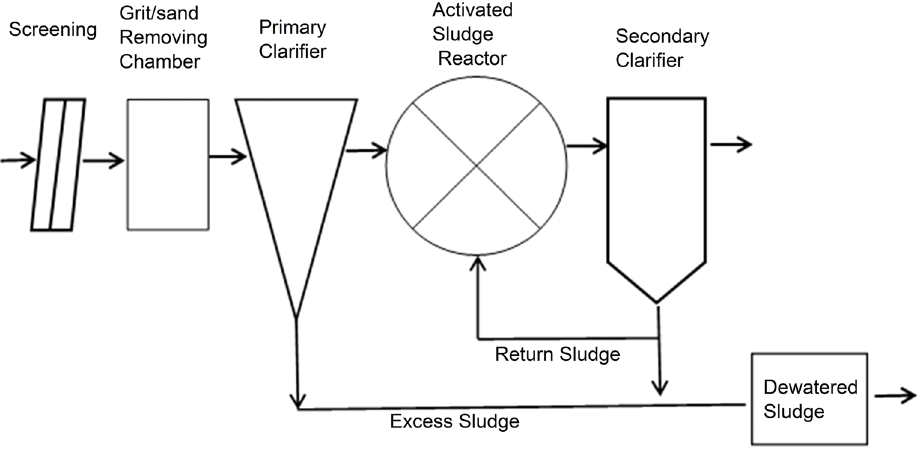
Figure 1. Process flow diagram for Zenin